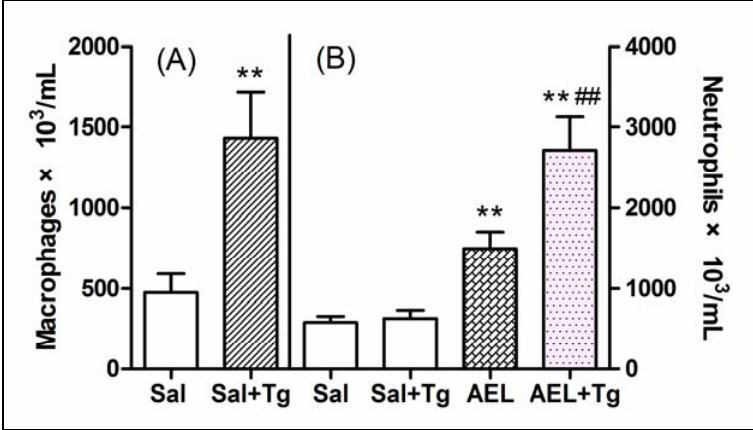
Figure 7. Thioglycollate potentiates the neutrophil migration induced by AEL. ( A ) Macrophage population in normal (Sal) and in Tg-pretreated animals (Sal + Tg); ( B ) Neutrophil migration induced by saline (1 mL/cavity) and AEL (200 μ g/cavity in 1 mL saline) in normal (Sal and AEL) and in Tg-pretreated animals (Sal + Tg and AEL + Tg). Results are mean ± S.D. (n = 6). ** p < 0.01 compared with saline and ## p < 0.01 compared with AEL.